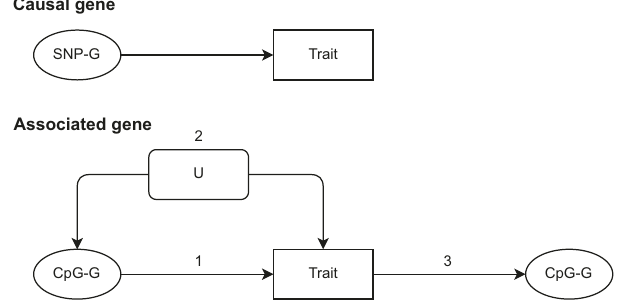
Fig. 1 | A diagramofcausal and associatedgenes. A causalgene isone where the product of that gene affects the trait of interest and in this study, we are assuming that SNPs identi fi ed in relation to a trait will affect these genes or tag SNPs that do (SNP-G). An associated gene is one where the product of that gene correlates with the trait of interest, but may not affect it. In this study, we are assuming that CpG sites identi fi ed in relation to a trait will map to these genes (CpG-G). The diagram showshowageneproductmaybecorrelatedwithatrait:1.byaffectingthetrait,2.